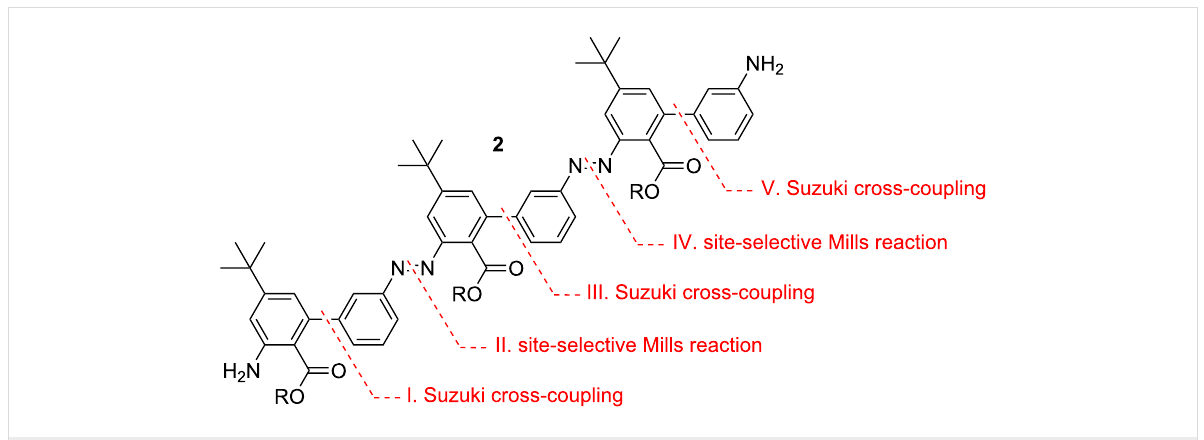
Figure 2: Synthetic strategy for the assembly of meta -substituted oligo-azobiphenyls 2 .